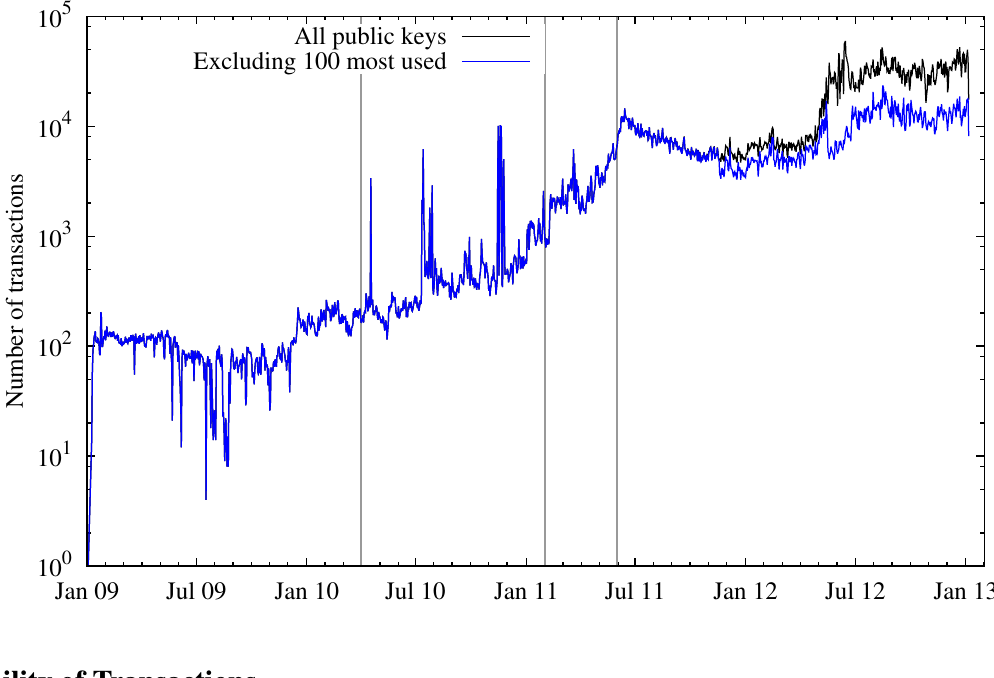
Figure 8. Total number of transactions (logarithmic